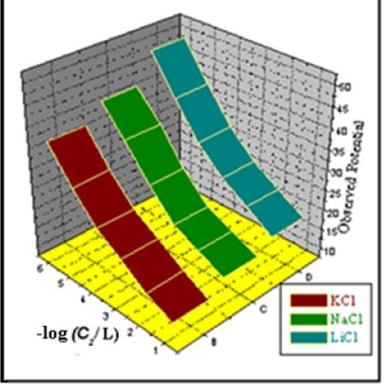
Plots of observed membrane potentials against logarithm of concentration for PVC–NP composite membrane.